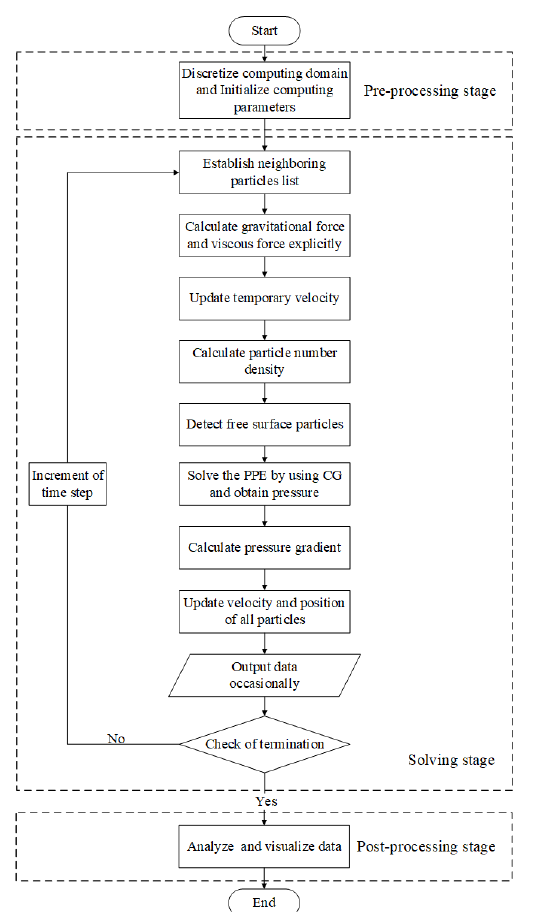
Figure 2. Flow chart of MPS numerical